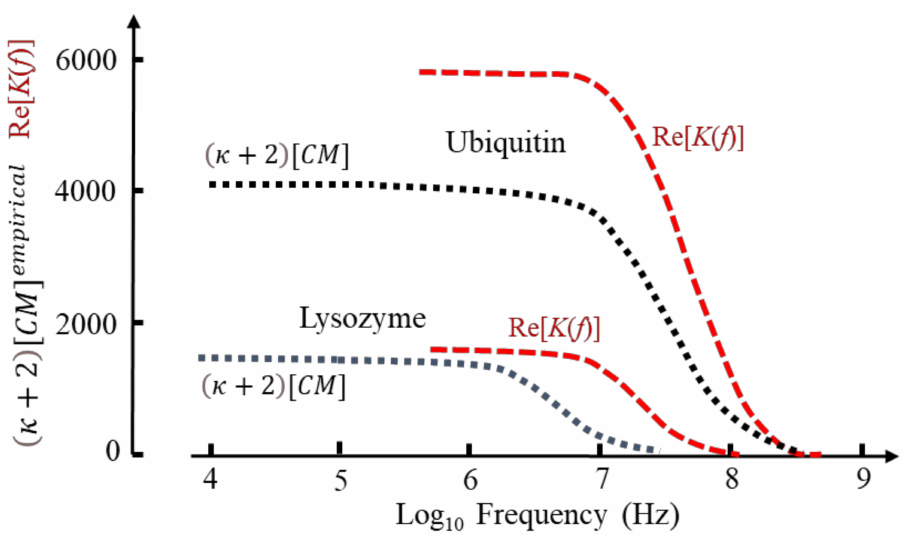
Figure 10. Frequency dependence of the DEP susceptibility factor Re [ K ] for ubiquitin and lysozyme [1], together with plots for their empirical factors ( κ + 2)[ CM ]